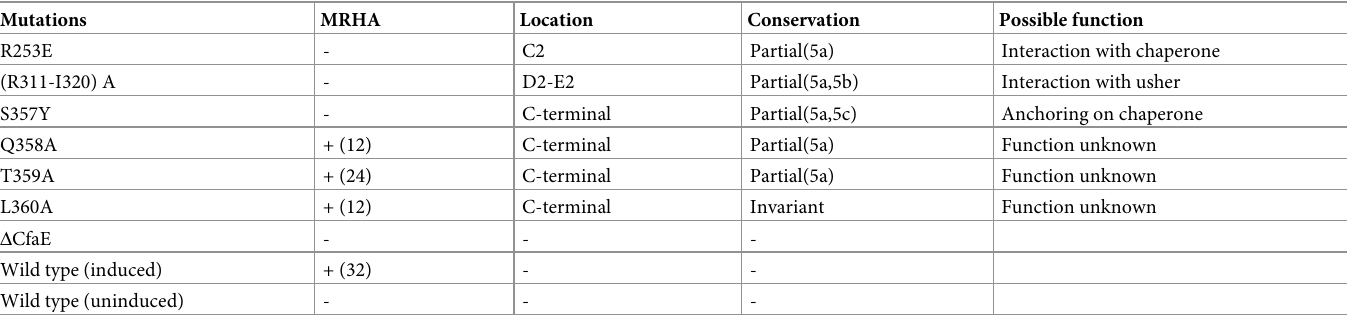
Table 2. Effects of CfaE mutations at mt CfaA-CfaE interface.